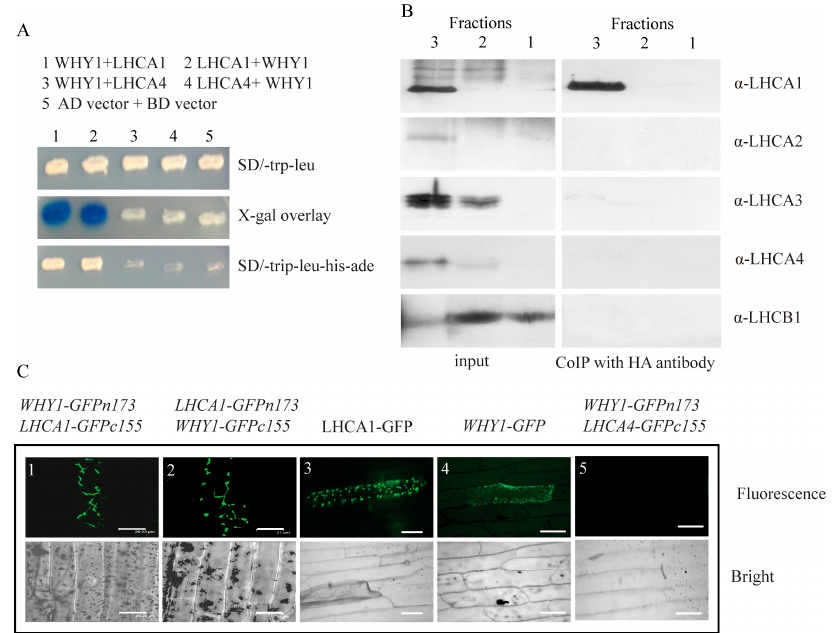
Figure 3. The interaction confirmation of WHY1 and LHCA1. ( A ) The interaction confirmation of WHY1 and LHCA1 by yeast two hybrid. Yeast two hybrid interaction detection growth selections and X-Gal agarose overlay assay indicate an interaction between WHY1 and LHCA1; ( B ) CoIP of WHY1 and LHCA1 from photosystem I containing thylakoid membrane complexes. As input to the thylakoid membrane fractions 1, 2, and 3 (see Supplementary Figure S1, 1, free pigments; 2, LHCII and photosystem II complexes; 3, photosystem I complexes) were used. Coimmunoprecipitation (CoIP) was performed with the antibody specific for the HA peptide. Precipitated proteins were separated by SDS-PAGE. Immunoreactions were performed with the antibody specific for LHCA1 (22 kD), followed by incubation with the antibody directed towards LHCA2 (23 kD), LHCA3 (25 kD), LHCA4 (22 kD), and LHCB1(20 kD) as control; ( C ) Confirmation of the interaction of WHY1 and LHCA1 by bimolecular fluorescence complementation assays (BiFC). The onion epidermal cells were transiently transformed with the full length WHY1 and the full length LHCA1. Constructs were fused to either c-myc-GFPn173 or HA-GFPc155 and vice versa. The WHY1 and LHCA1 fused to full length GFP and empty vector were used as controls. All constructs were under the control of the 35S promoter. Fluorescence images are shown on the upside and bright field images are shown on the underside, respectively. C1: WHY1-GFPn173 + LHCA1-GFPc155; C2: LHCA1-GFPn173 + WHY1-GFPc155; C3: WHY1-GFP; C4: LHCA1-GFP; C5: WHY1-GFPn173 + LHCA4-GFPc155; C1-2: scale bar 21 μ m; C3-5: scale bar 100 μ m.